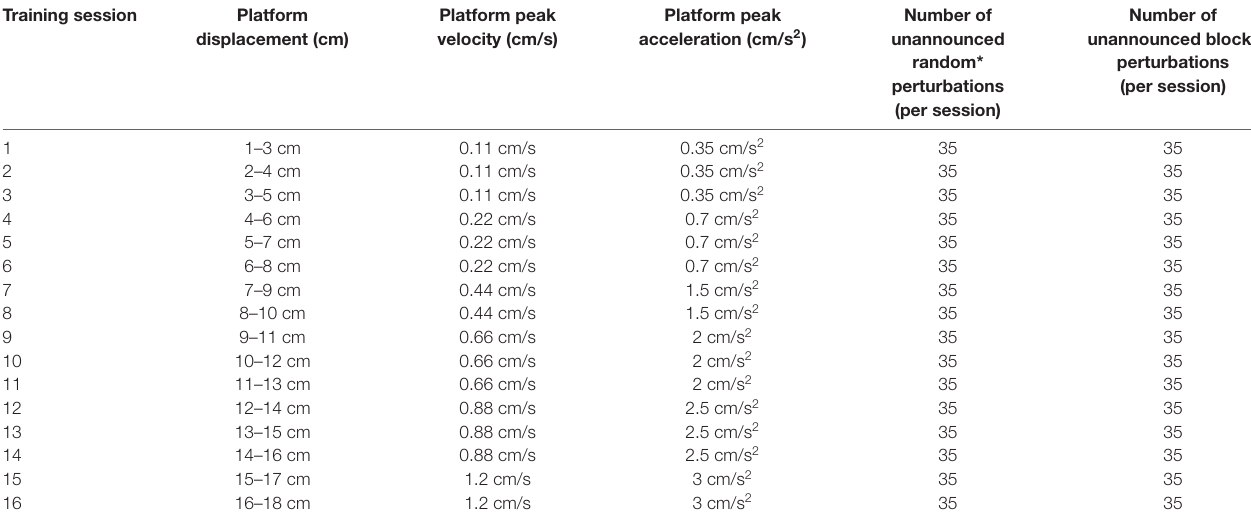
TABLE 3 | Details of the perturbation protocols used in intervention training programs. Training